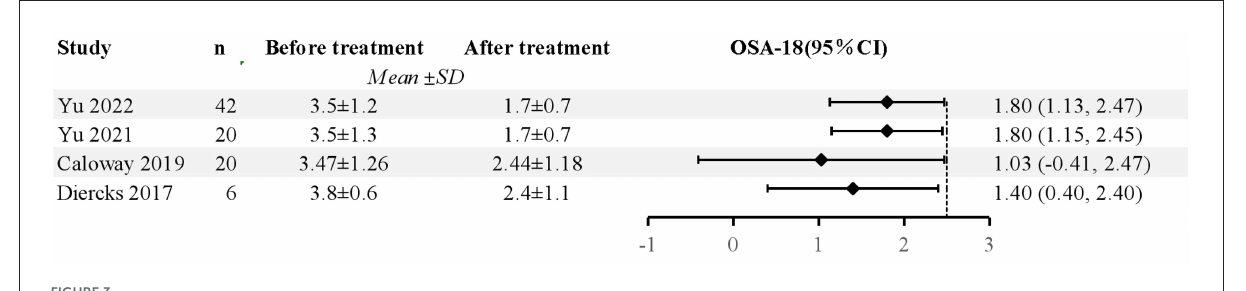
FIGURE3 The forest plot of studies investigating